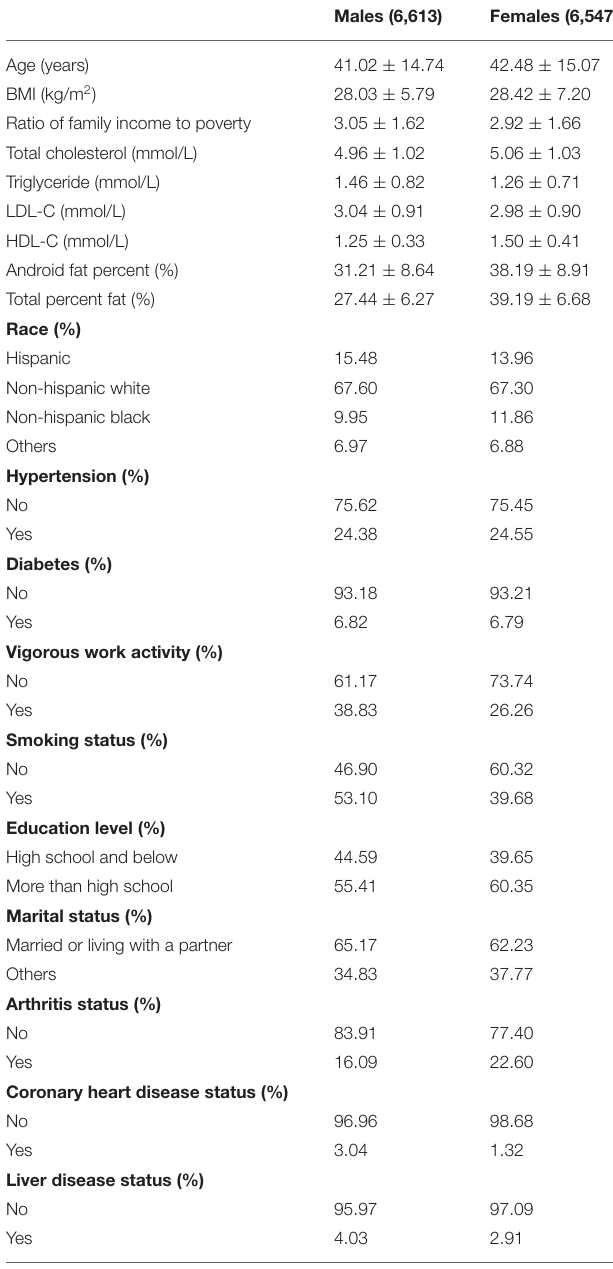
TABLE 1 | The characteristics of